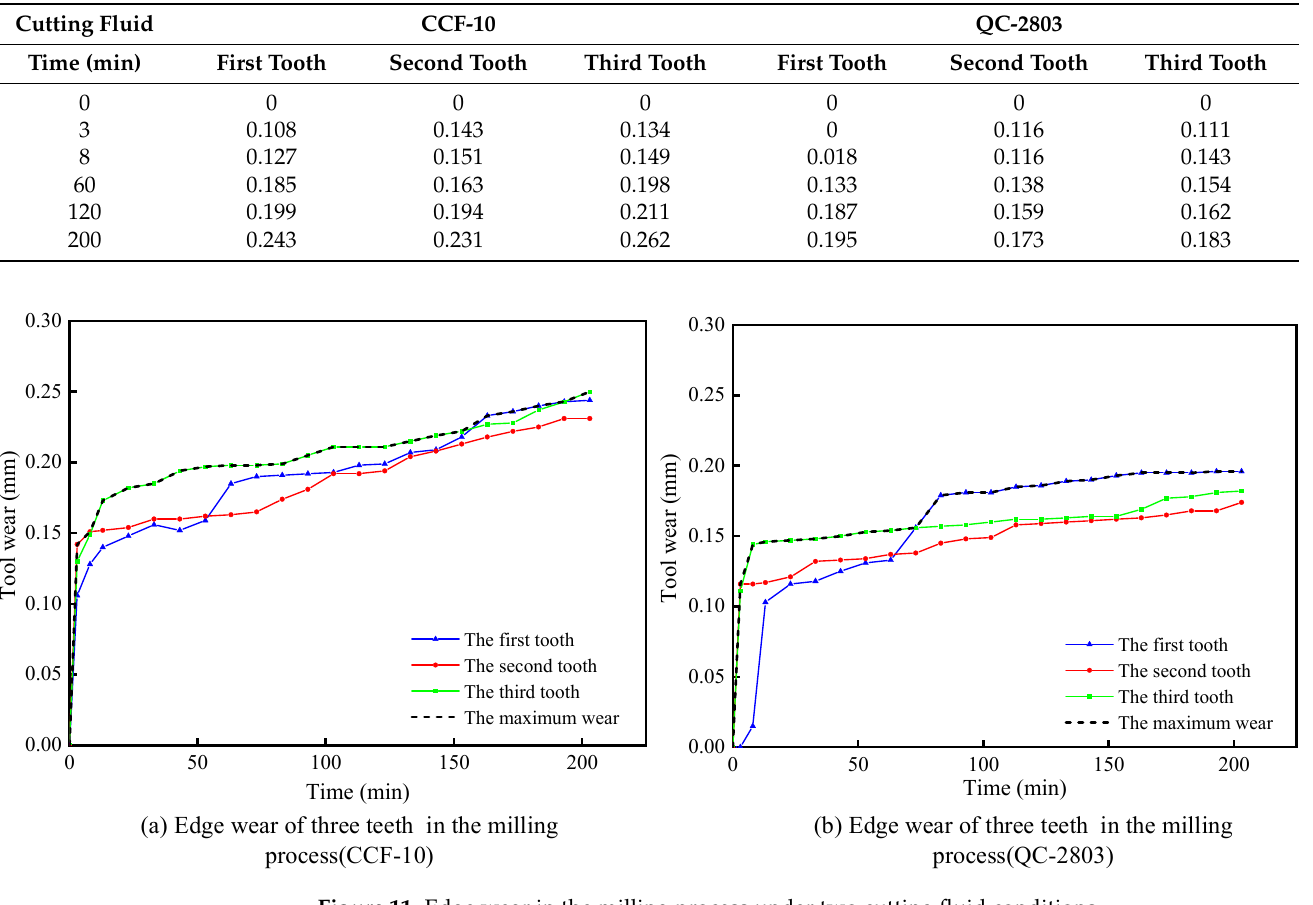
Figure 13. SEM images of cutting-edge wear in the case of CCF-10.